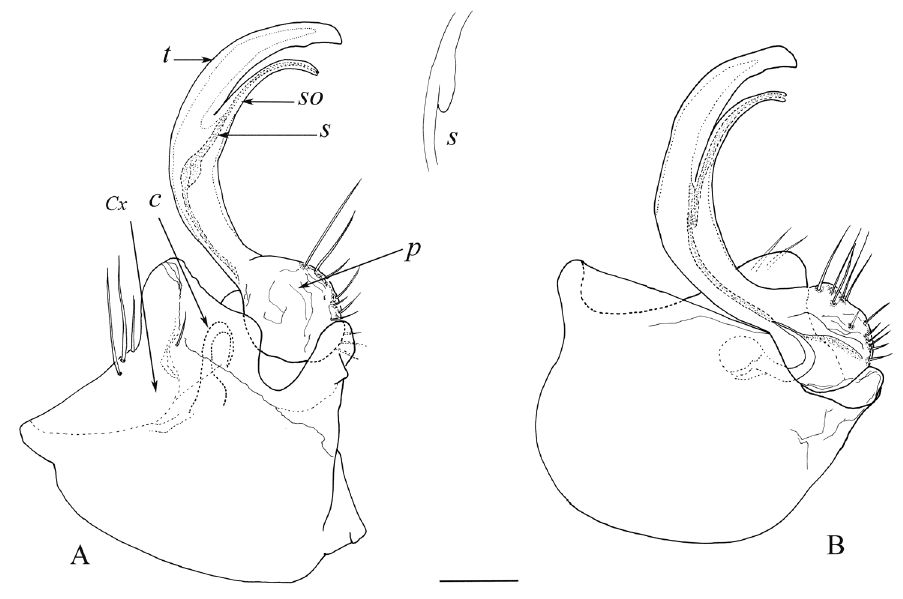
Figure 3. Haplocookia enghoffi sp. n. ♂ paratype: A Left gonopod, mesal view B Left gonopod, postero-lateral view. Abbreviations: C cannula, Cx Coxa, p prefemur, S seminal groove, So solenomere, t tibiotarsus. Scale bar 0.1